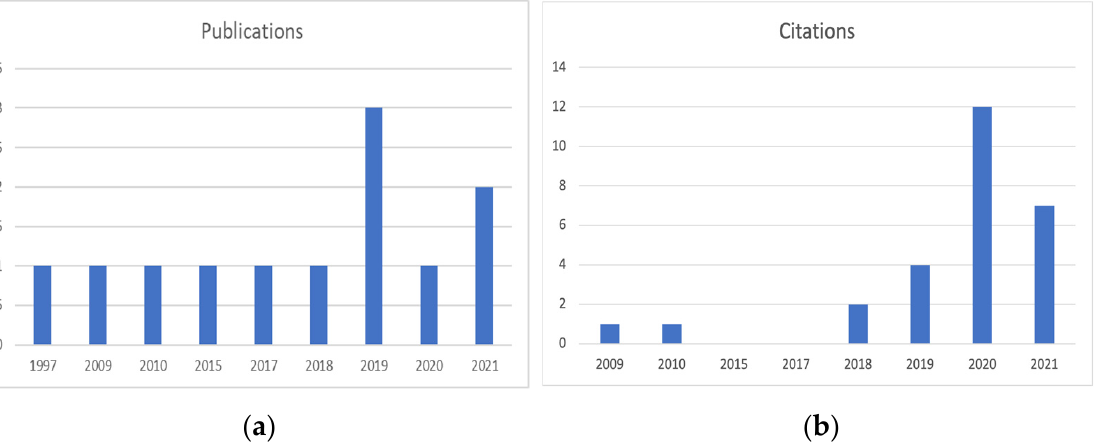
Figure 1. Dynamics on publications ( a ) and citations ( b ) on social entrepreneurship in Georgia. Source: Web of Science.